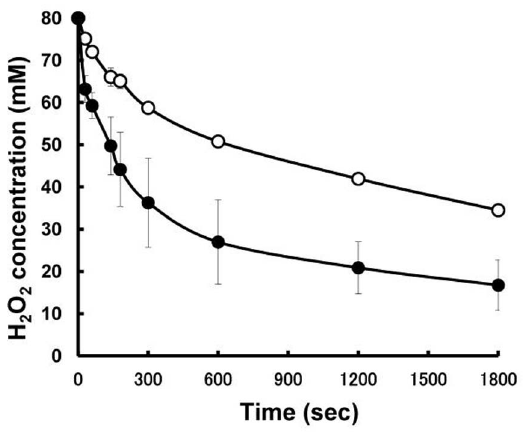
Figure 5. Inner circumference localization ratio of catalase in strain T-2-2 T cells on the basis of particles in ultrathin sections exhibiting catalase immunolocalization. Cells from 5 (n=19), 14 (n=33) and 24 (n=47) h cultures are indicated by open, blue filled and red filled circles, respectively. Particles locating within 50 nm from the surface of the cell are considered as surface- localized particles. Black bars indicate the average inner circumference localization ratio in each growth phase.